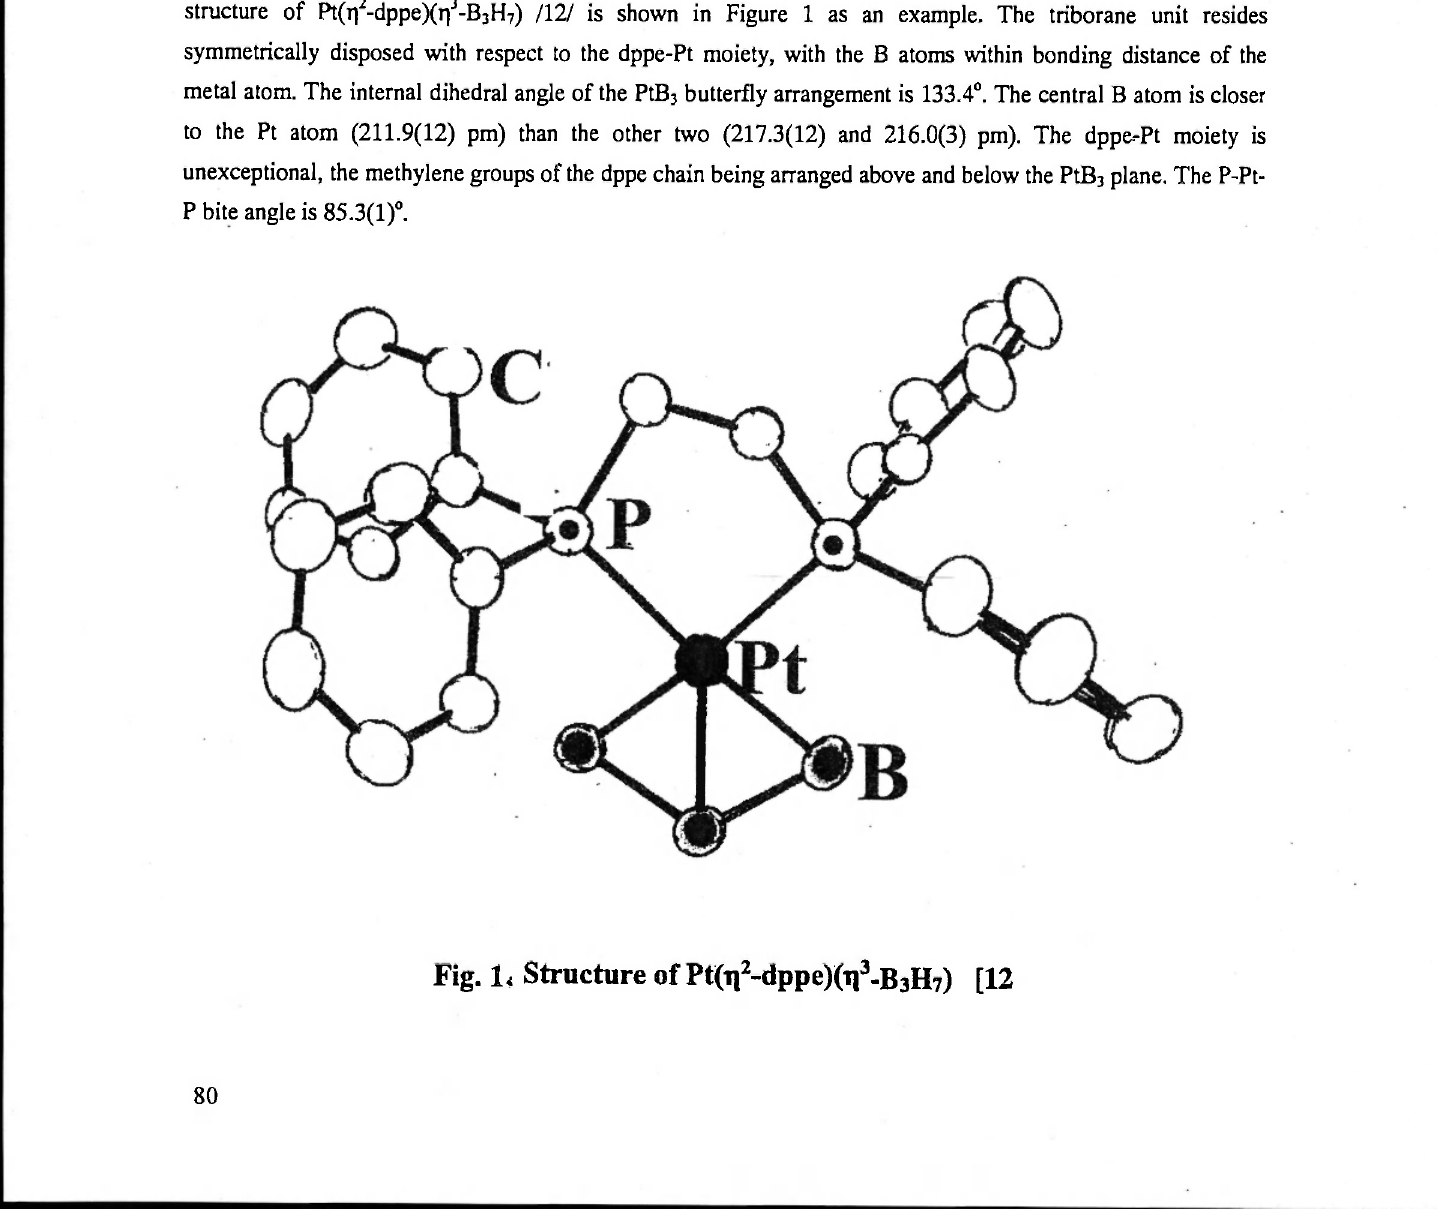
Fig. h Structure of Ρί(η 2 -άρρε)(η 3 -Β